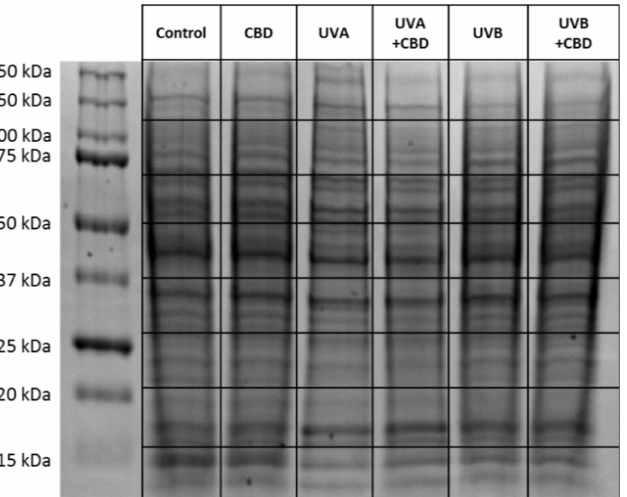
Figure 9. SDS–PAGE separation and staining with Coomassie brilliant blue R-250 of proteins from control keratinocytes and irradiated with UVA (30 J/cm 2 ), UVB (60 mJ/cm 2 ) or/and treated with cannabidiol (CBD, 4 µ M) in a three-dimensional (3D) culture model. The grid indicates the borders of the protein migration zones. Original photo of the gel is added in Supplementary Figure